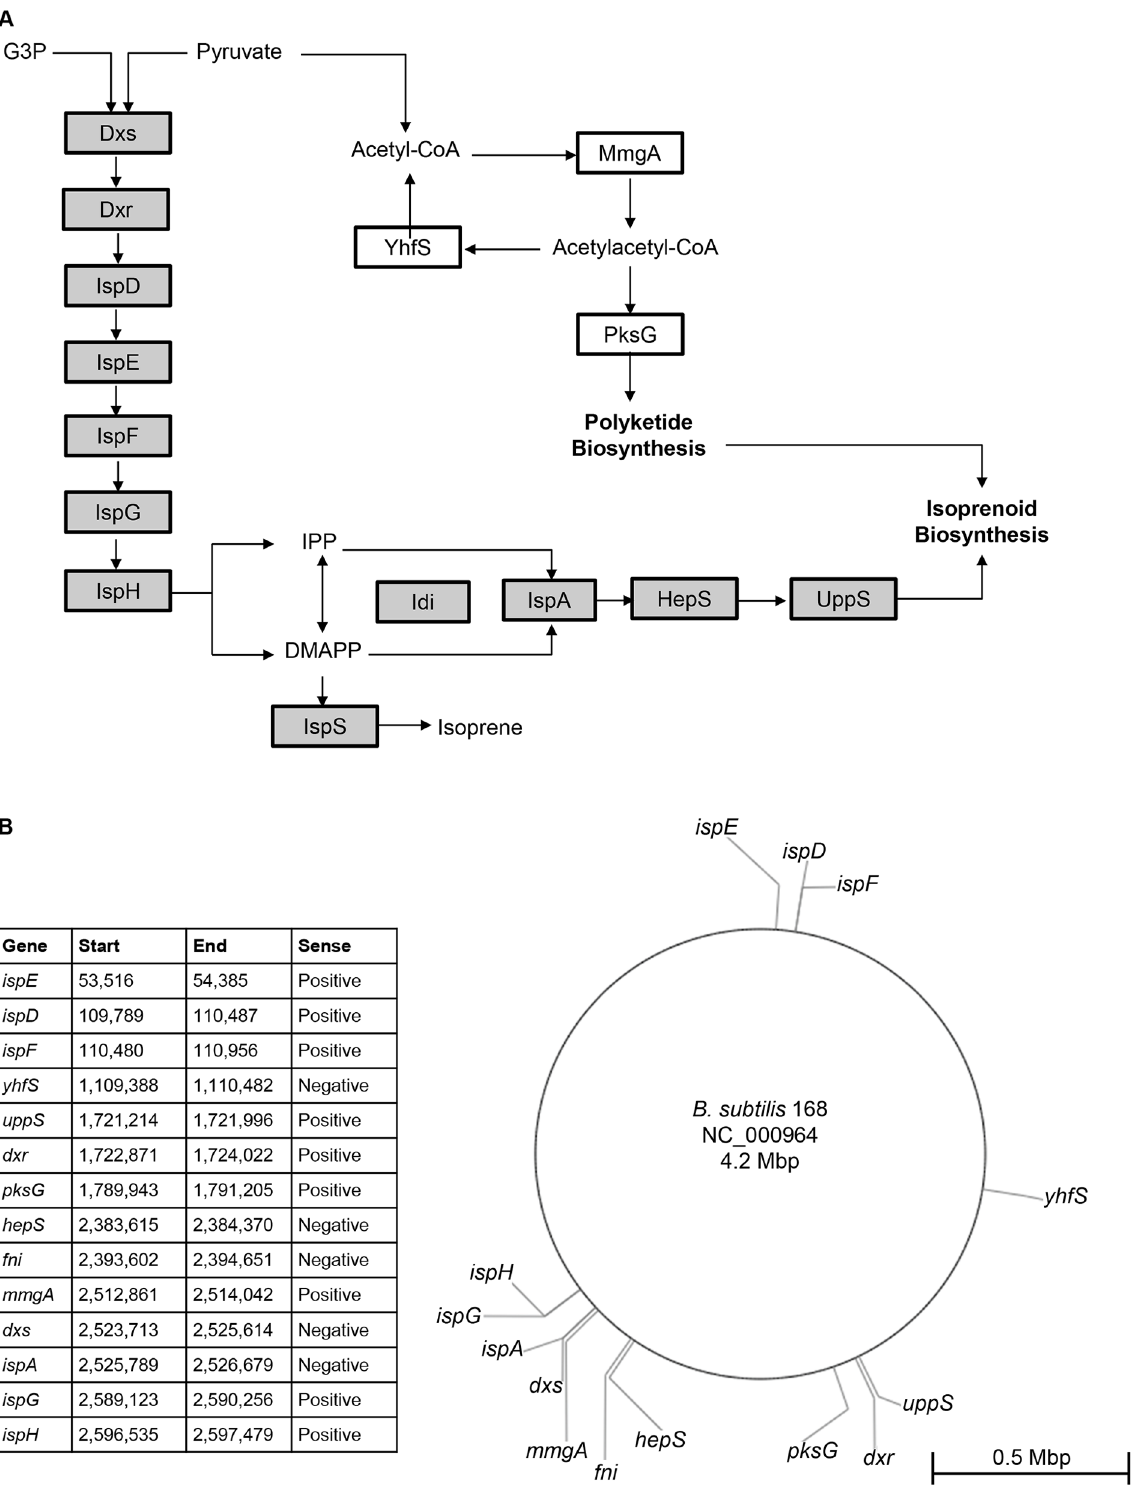
Figure 2. Terpenoid pathway genes in B.subtilis. A, Metabolic pathway layout of terpenoid genes. The 1-deoxy-D-xylulose-5-phosphate (DXP) pathway enzymes (shaded) are: Dxs, 1-Deoxy-D-xylulose-5-phosphate synthase; Dxr, 1-deoxy-D-xylulose-5-phosphate reductoisomerase; IspD, 4- diphosphocytidyl-2-C-methyl-D-erythritol synthase; IspE, 4-diphosphocytidyl-2-C-methyl-D-erythritol kinase; IspF, 2C-methyl-D-erythritol 2,4- cyclodiphosphate synthase; IspG, 1-hydroxy-2-methyl-2-(E)-butenyl 4-diphosphate synthase; IspH, 1-hydroxy-2-methyl-butenyl 4-diphosphate reductase; Idi (encoded by fni ), isopentenyl pyrophosphate isomerase; IspA, farnesyl diphosphate synthase; HepS, heptaprenyl diphosphate synthase component I; UppS, undecaprenyl pyrophosphate synthetase; IspS, putative isoprene synthase. The mevalonate (MVA) pathway enzymes (white) are: MmgA, degradative acetoacetyl-CoA thiolase; YhfS, hydroxymethylglutaryl CoA synthase; PksG, 3-hydroxy-3-methylglutaryl-ACP synthase. Metabolite